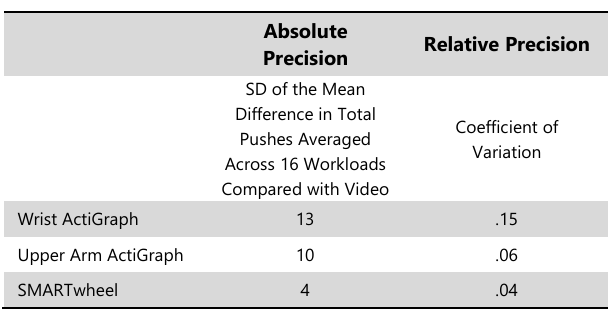
Table 3 . Precision of ActiGraph GT3X+ Devices Worn on the Wrist and Upper Arm and SMARTWheel for Capturing Pushes During Manual Wheelchair Propulsion Across 16 Trials of Increasing Workloads in a Sample of 11 Young Persons.